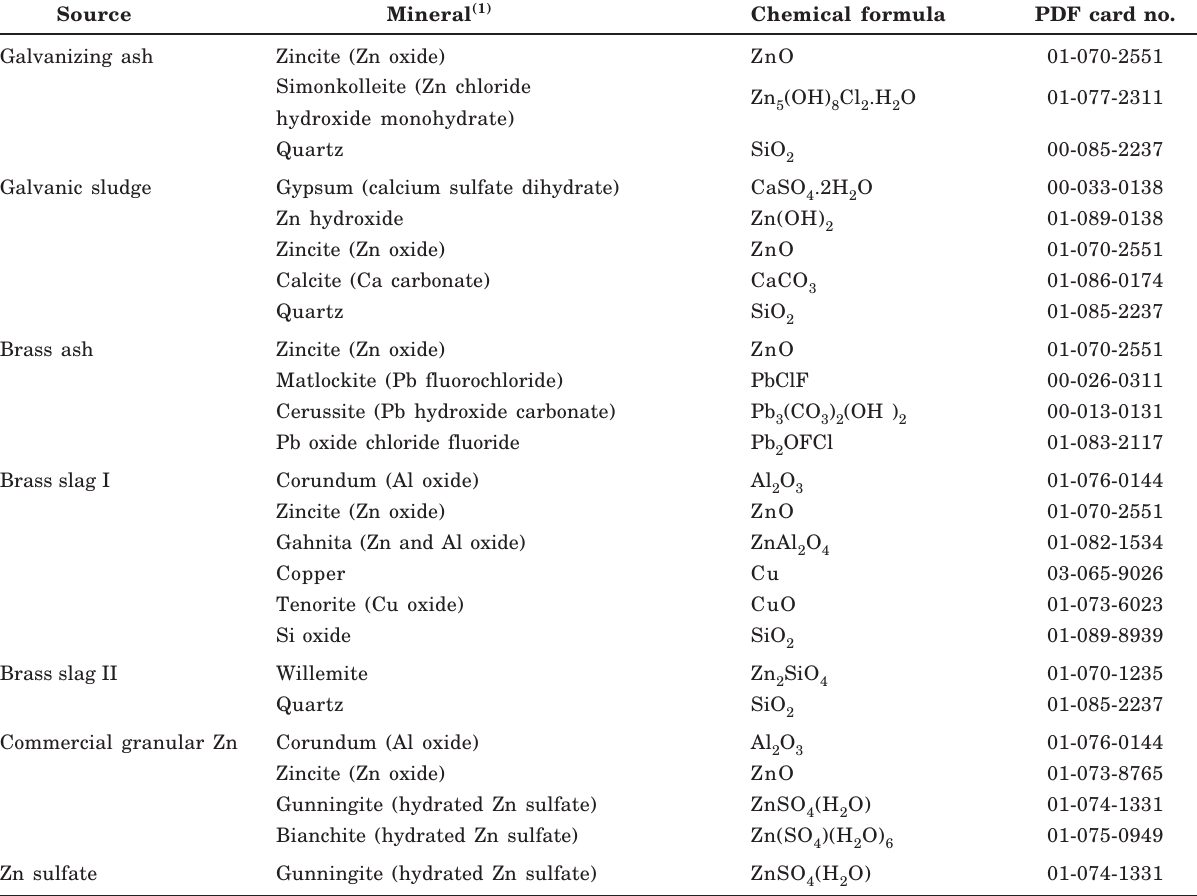
(1) More details see Souza